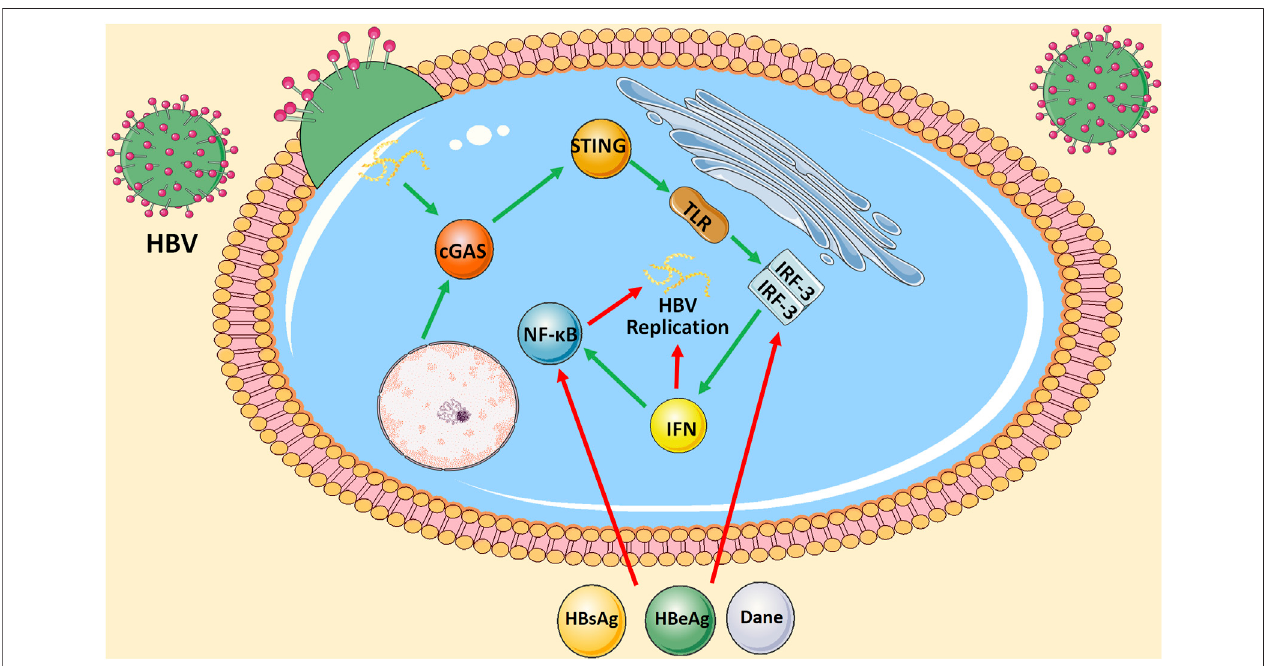
FIGURE 2 | Interaction between cGAS-STING signaling pathway and HBV infection. On the one hand, cGAS-STING signaling either produces IFN by activating downstream TLR3 or further activates NF- κ B signaling pathway to inhibit intrahepatic HBV replication. On the other hand, HBsAg, HBeAg, or HBV virions inhibit TLR- induced antiviral activity of hepatocytes by suppressing the activation of IRF-3 and NF- κ